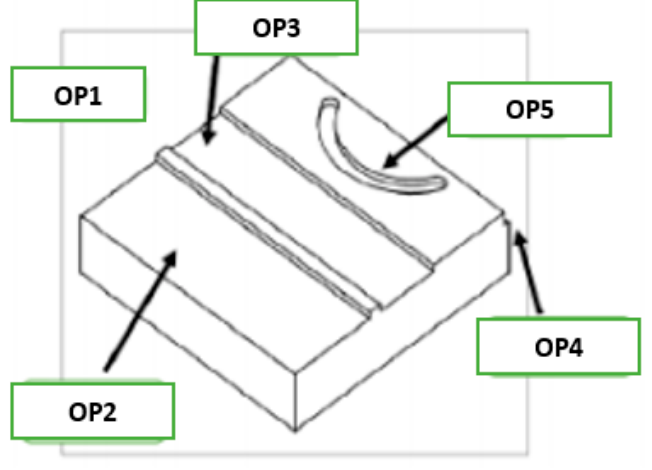
Figure 5. Machined part design during testing.